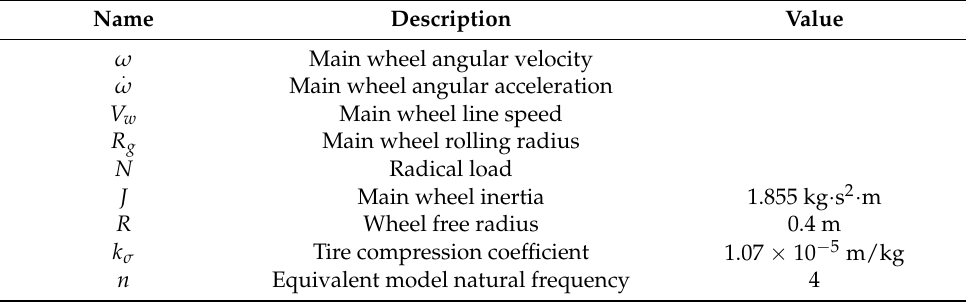
Table 4. Parameters of the main wheel.